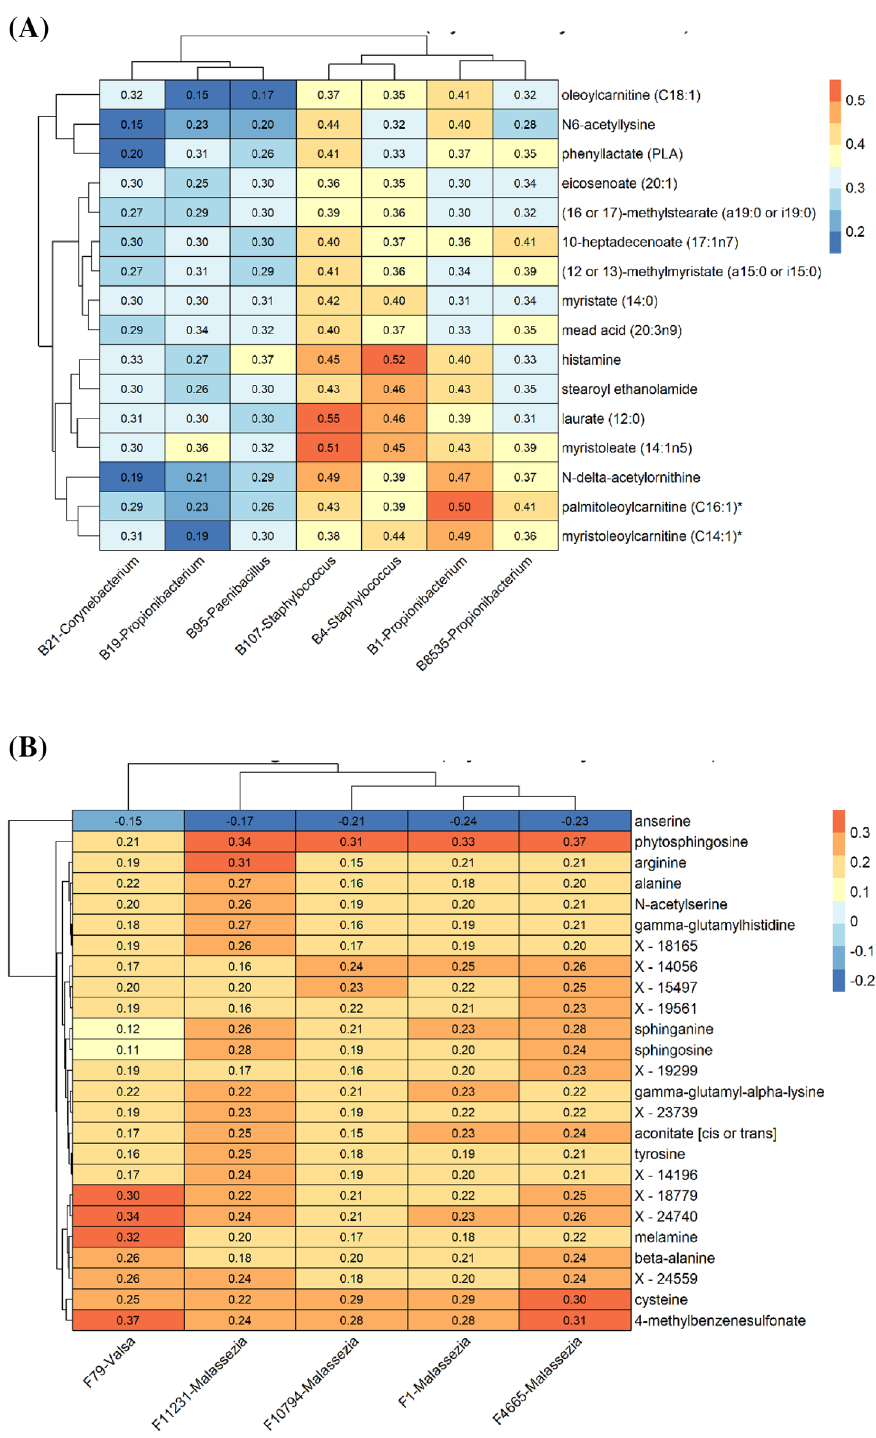
Figure 5. Heatmaps of the cross-correlation between OTU abundance and metabolites selected by sparse Canonical Correlation Analysis (sCCA), adjusted for city confounder. The values in the heatmap correspond to Pearson’s correlation coefficient. ( A ) bacterial OTU. ( B ) fungal OTU. Figures were created using the R software: R Core Team (2017), R Foundation for Statistical Computing, Vienna, Austria. URL https:// www.R- proje ct.